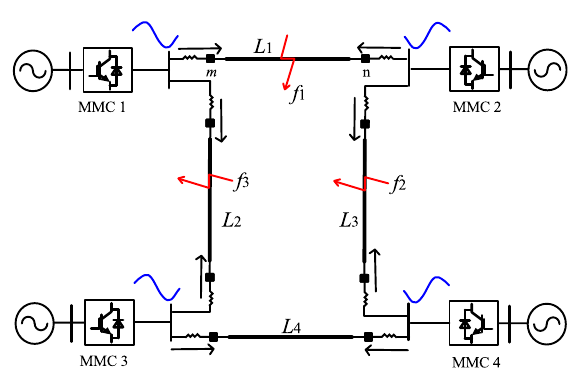
Fig. 7 Four-terminal hybrid MMC DC